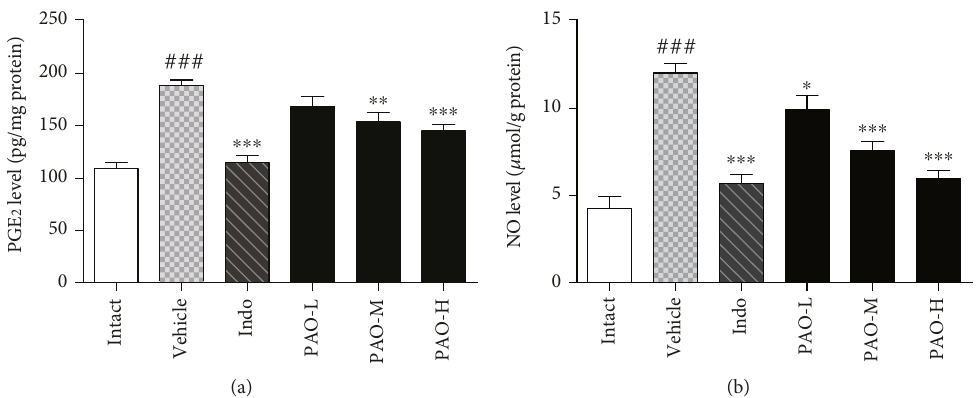
Figure 7: E ff ect of PAO on the levels of PGE (a) and NO (b) in carrageenan-induced mouse paw. Indo: indomethacin (10 mg/kg); PAO-L: 2 low dose of PAO (10 mg/kg); PAO-M: medium dose of PAO (20 mg/kg); PAO-H: high dose of PAO (40 mg/kg). Data were expressed as means ± SEM. ( n = 10 ), ### p < 0 001 versus the intact group. ∗ p < 0 05 , ∗∗ p < 0 01 , and ∗∗∗ p < 0 001 versus the vehicle